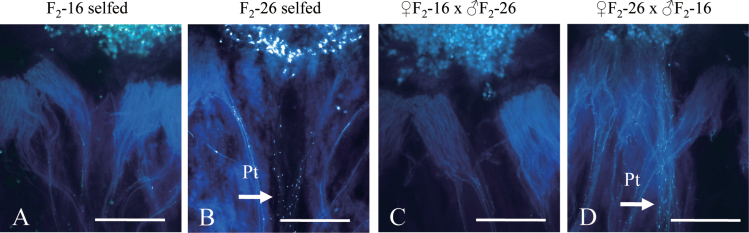
Reciprocal crosses with CO2 treatment between two S
46 homozygous individuals from the F2 population with different RLSICO2. (A) CO2-sensitive F2 self-pollination. (B) CO2-insensitive F2 self-pollination. (C) A CO2-sensitive F2 pistil pollinated with pollen from a CO2-insensitive F2. (D) A CO2-insensitive F2 pistil pollinated with pollen from a CO2-sensitive F2. Pt, pollen tubes. Bar=1000 μm. n=3.